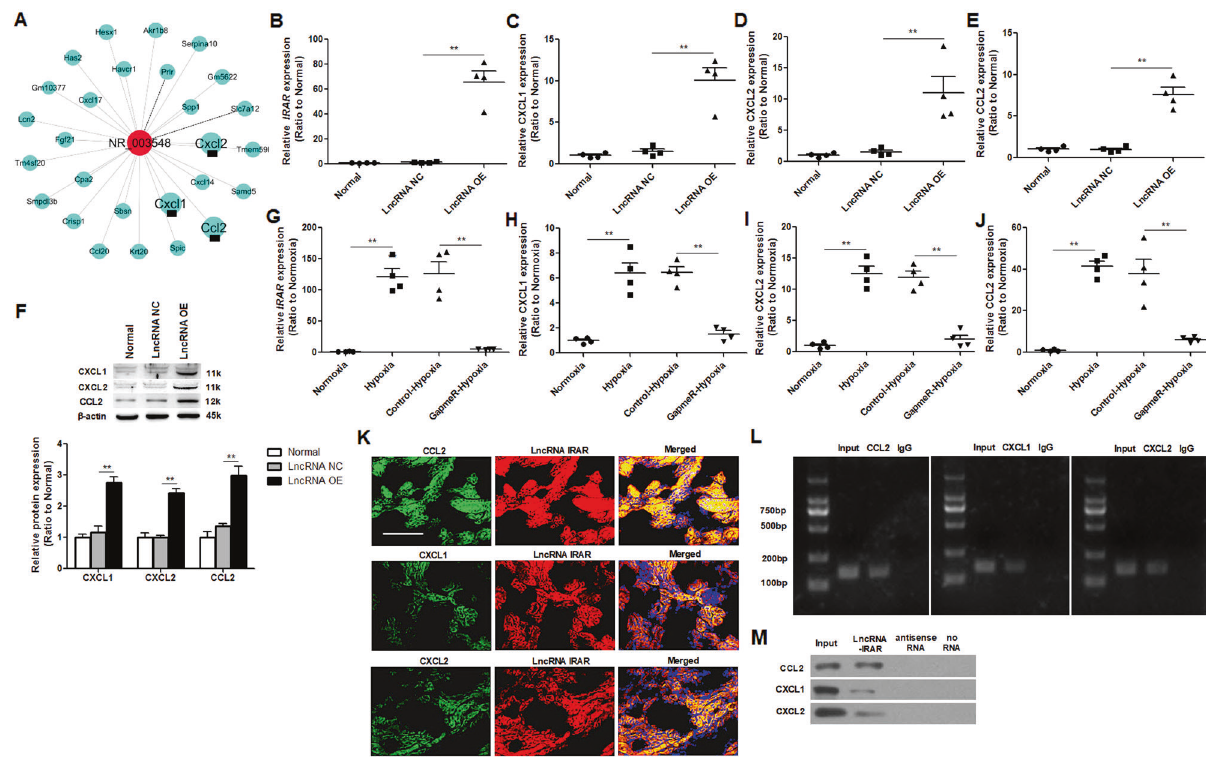
Fig. 5 IRAR regulates chemokine expression. A Co -expression network of IRAR and differentially expressed mRNAs. The solid line indicates positive regulation and the dotted line indicates negative regulation. B qRT-PCR analysis of IRAR in mTECs transfected with IRAR overexpressing lentivirus (LncRNA-OE) or Negative lentivirus (LncRNA-NC). C – E qRT-PCR analysis of CXCL1 ( C ), CXCL2 ( D ), CCL2 ( E ) in mTECs transfected with IRAR overexpressing lentivirus or Negative lentivirus. F Western blot analysis of CXCL1, CXCL2 and CCL2 in mTECs transfected with IRAR overexpressing lentivirus or Negative lentivirus.. Data are means from three independent experiments. G – J qRT-PCR analysis of IRAR ( G ), CXCL1 ( H ), CXCL2 ( I ) and CCL2 ( J ) in mTECs. mTECs were transfected with GapmeR IRAR (GapmeR-Hypoxia) or Negative control (Control-Hypoxia) for 48h, then treated with hypoxia. K RNA fl uorescence in situ hybridization (FISH) assays indicated co-expression between IRAR and CXCL1, CXCL2, CCL2 in the kidney at 24 h after ischemia reperfusion. Scale bar, 100 μ m. L RNA immunoprecipitation (RIP) experiments were performed using antibodies against CXCL1, CXCL2 and CCL2. RIP enrichment was determined relative to the input controls. M RNA pulldown assays were performed in tubular epithelia cells to examine the association of IRAR with CXCL1, CXCL2 and CCL2. Data represent mean ± SEM. n = 4. ** p <